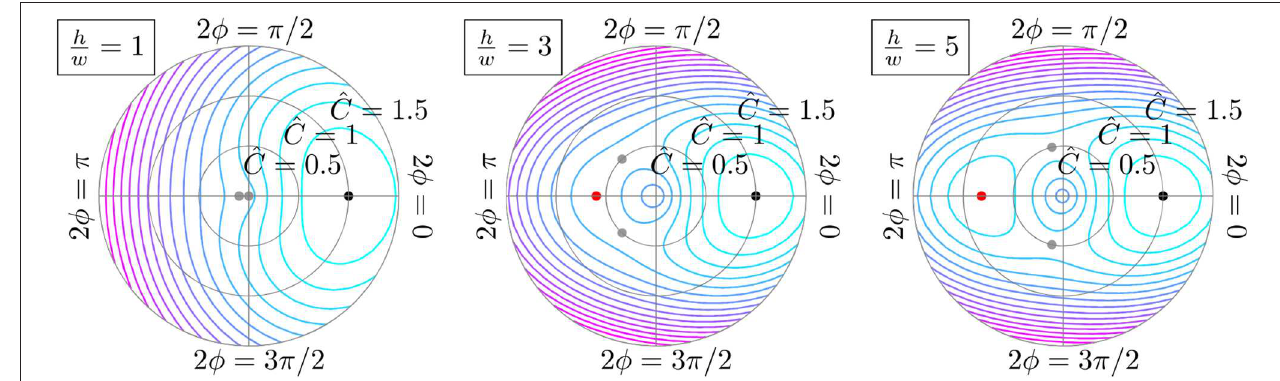
FIGURE 3 | The dimensionless energy, ˆ U , can be calculated for all possible configurations of curvature and rotation, when specific local geometries are chosen. The three polar plots were made by fixing w ( 1) and varying h for a rectangular ligament section. The initial geometry is shown in black, a second stable geometry in red, = and unstable equilibria in gray.